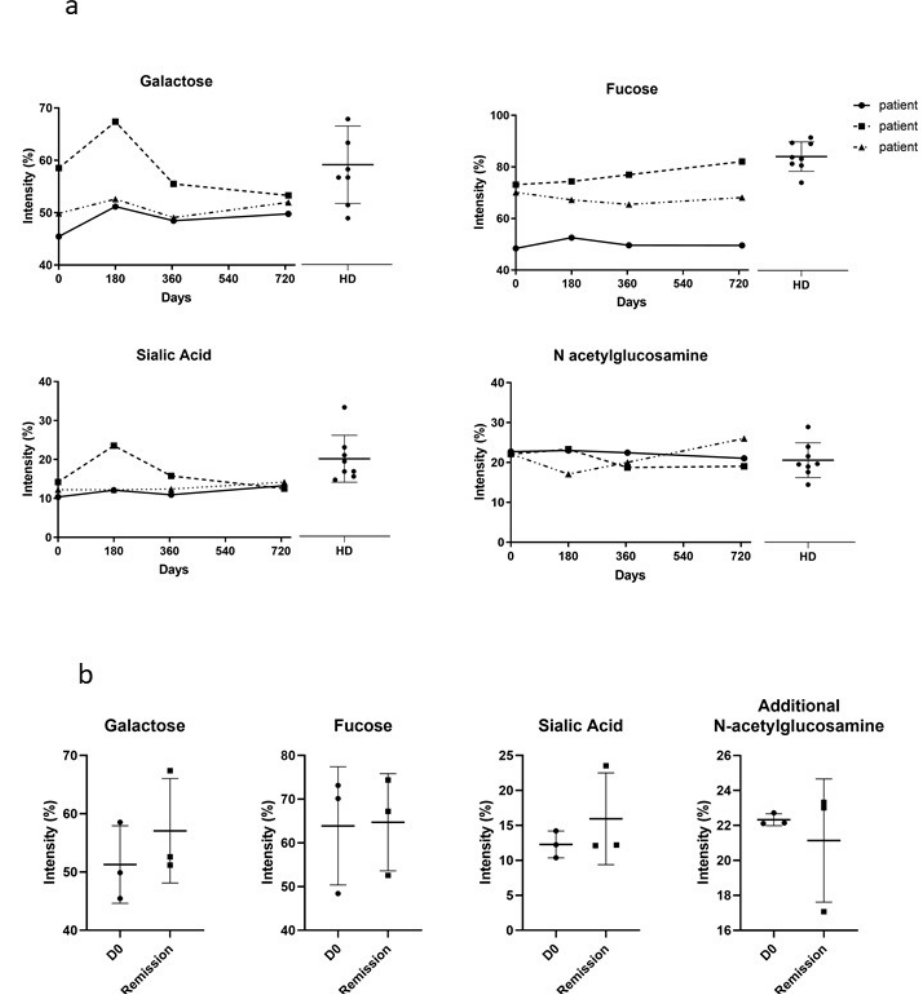
Figure 4. Study of the N -glycan profiles of IgG. ( a ) Comparison of the IgG galactosylation, fucosylation, sialylation and sylation, sialylation and presence of additional N -acetylglucosamine in healthy donors (HD) and presence of additional N -acetylglucosamine in healthy donors (HD) and pemphigus patients in active phase (D0). ( b ) pemphigus patients in active phase (D0). ( b ) Comparison of the IgG galactosylation, fucosylation, Comparison of the IgG galactosylation, fucosylation, sialylation and presence of additional N -acetylglucosamine in active sialylation and presence of additional N -acetylglucosamine in active (D0) and remission phase of (D0) and remission phase of pemphigus patients. HD: n = 8; patients: n = 3. pemphigus patients. HD: n = 8; patients: n =